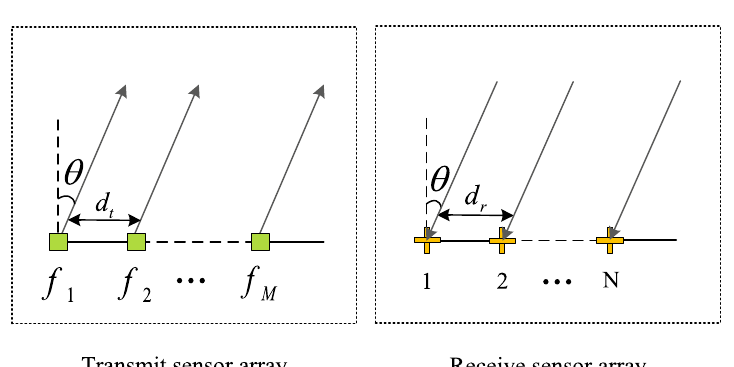
Fig. 1 A monostatic polarimetric FDA-MIMO radar with a transmit FDA having M sensors and a receive array having N cross dipole